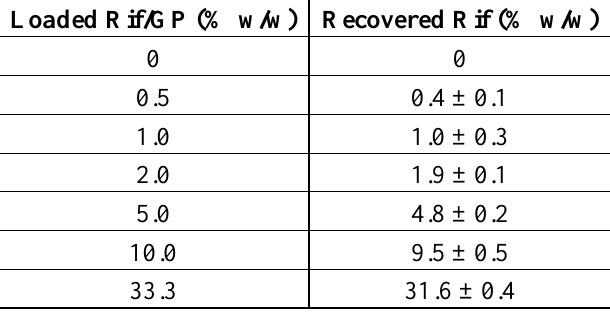
Table 1. Correlation between loaded amount of Rif/GP and actual Rif recovered as determined from spectrophotometric measurement following enzymatic digestion of GP-Rif samples. (% recovered Rif indicates the average value of three measurements from two different samples for each